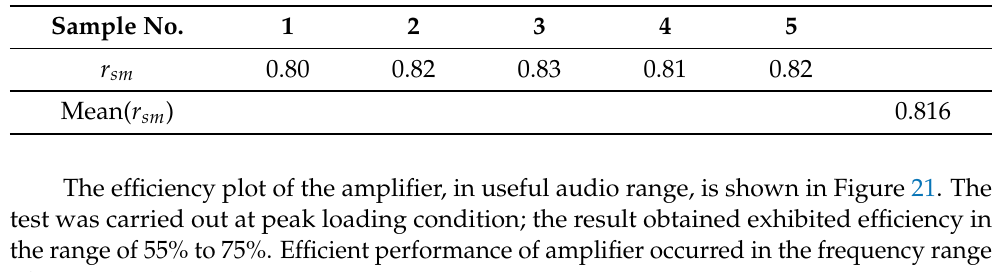
Table 7. Correlation coefficient, r sm , between ( v s , i o ) for musical signal input.